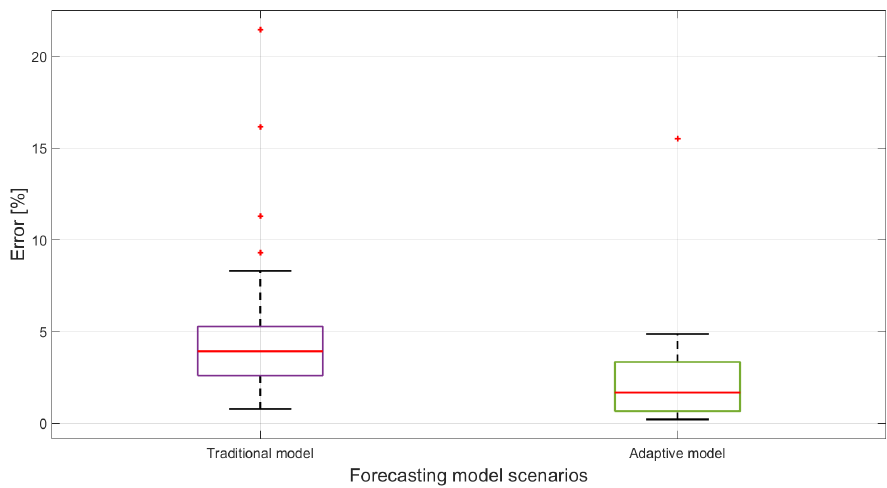
Figure 15. Box plot analysis for errors of adaptive and traditional forecast